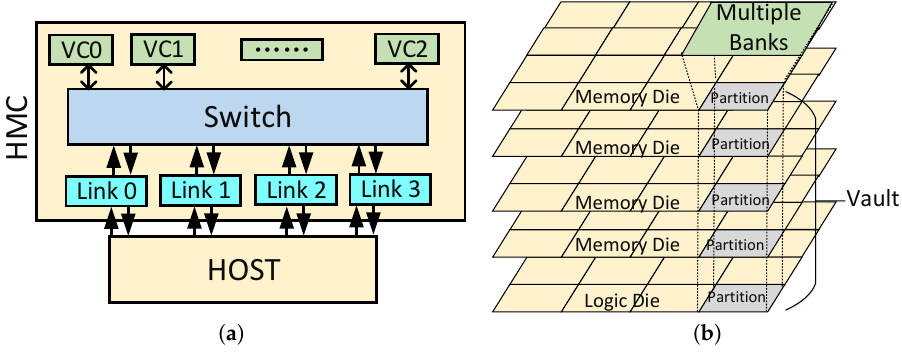
Figure 1. Overview and structure of the Hybrid Memory Cube (HMC). DRAM: Dynamic Random-Access Memory; TSV: Through-Silicon Via. ( a ) Overview of the HMC. ( b ) Structure of the